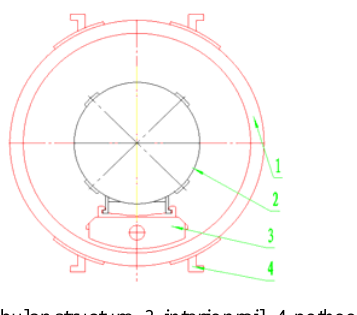
Figure1 Position relationship between tubular-structure and cover